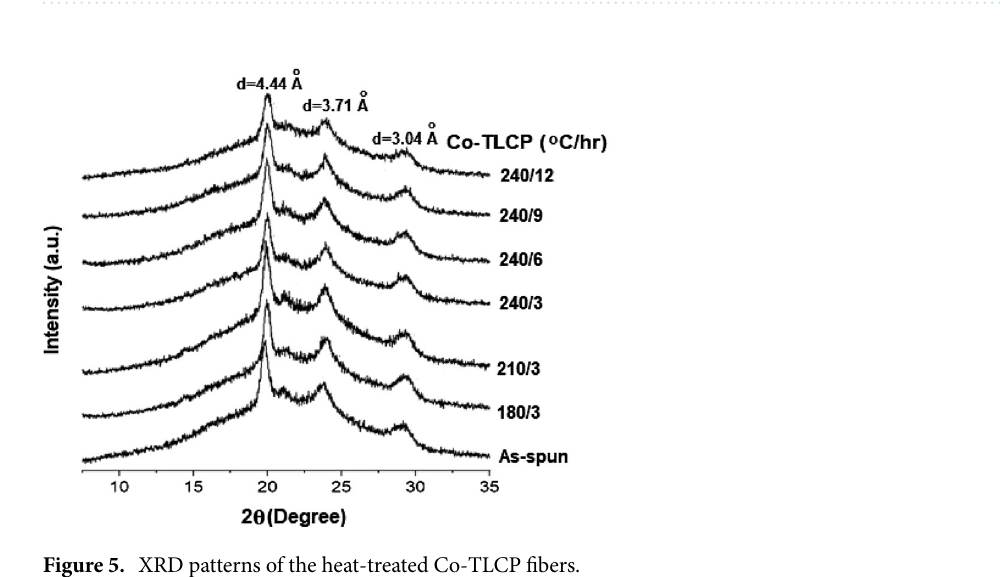
Figure 5. XRD patterns of the heat-treated Co-TLCP